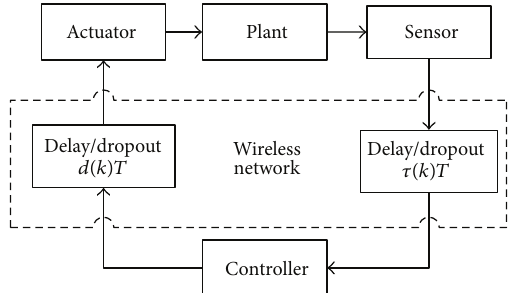
Figure 2: Wireless networked system digraph with predictor. where